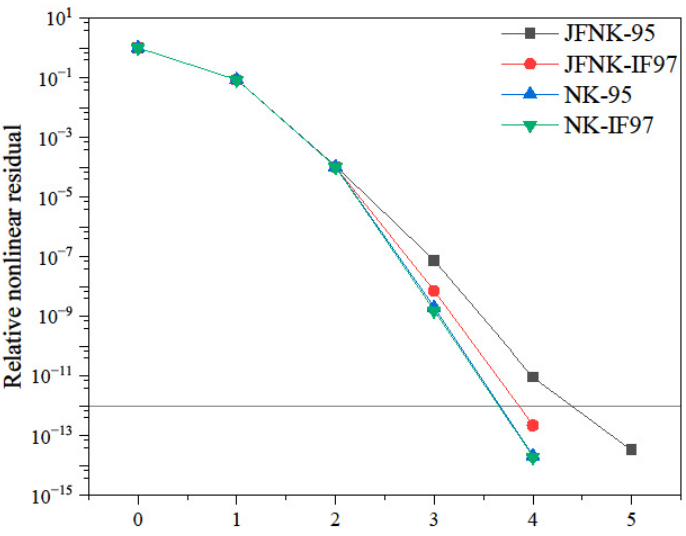
Figure 6. Nonlinear residual history in steady-state HTR-10 steam generator simulation. In order to further investigate the performance of the backward equation method, comparisons between two water properties formulations are made in the steady case. Since the residual evaluations are needed in the linear iteration process of the JFNK method, the water properties formulations might affect the linear solution. Linear residual